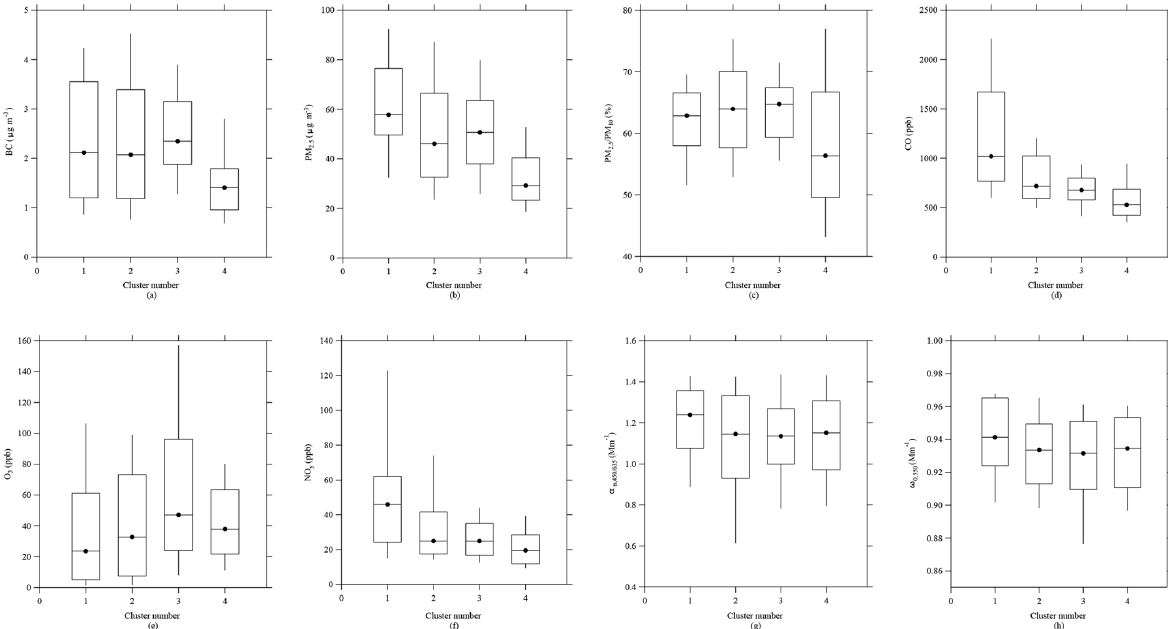
Figure 12. The 10th, 25th, 50th, 75th, and 90th percentile values in each cluster of back trajectories in the fall of 2016 of (a) BC, (b) PM 2 . 5 ,